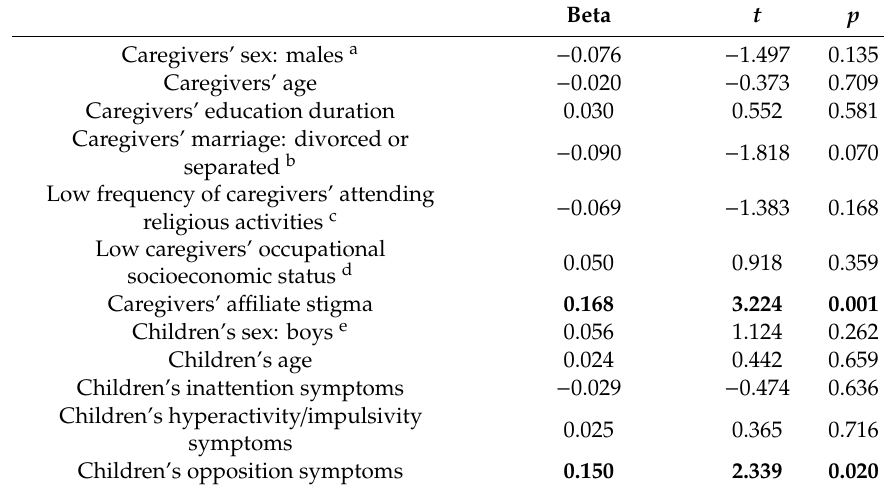
Table 4. Factors related to the numbers of etiologies of ADHD attributed by the